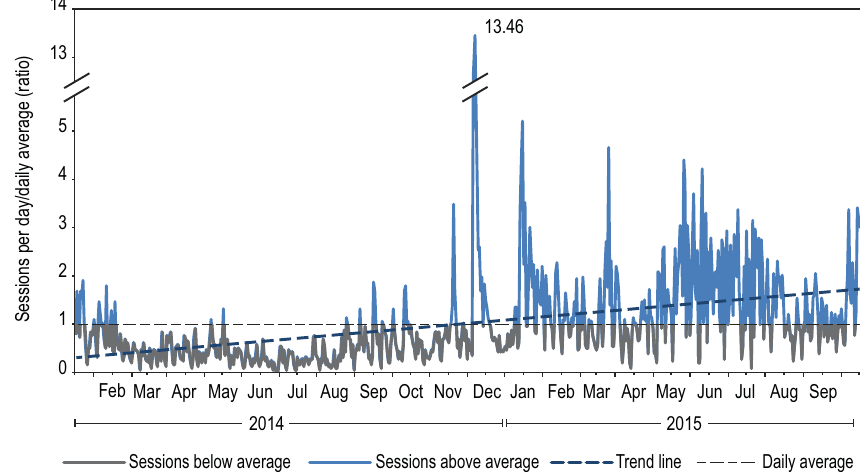
Figure 4. Daily average access number to the POLARIS website in the 638-day period from 16 January 2014 to 15 October 2015.